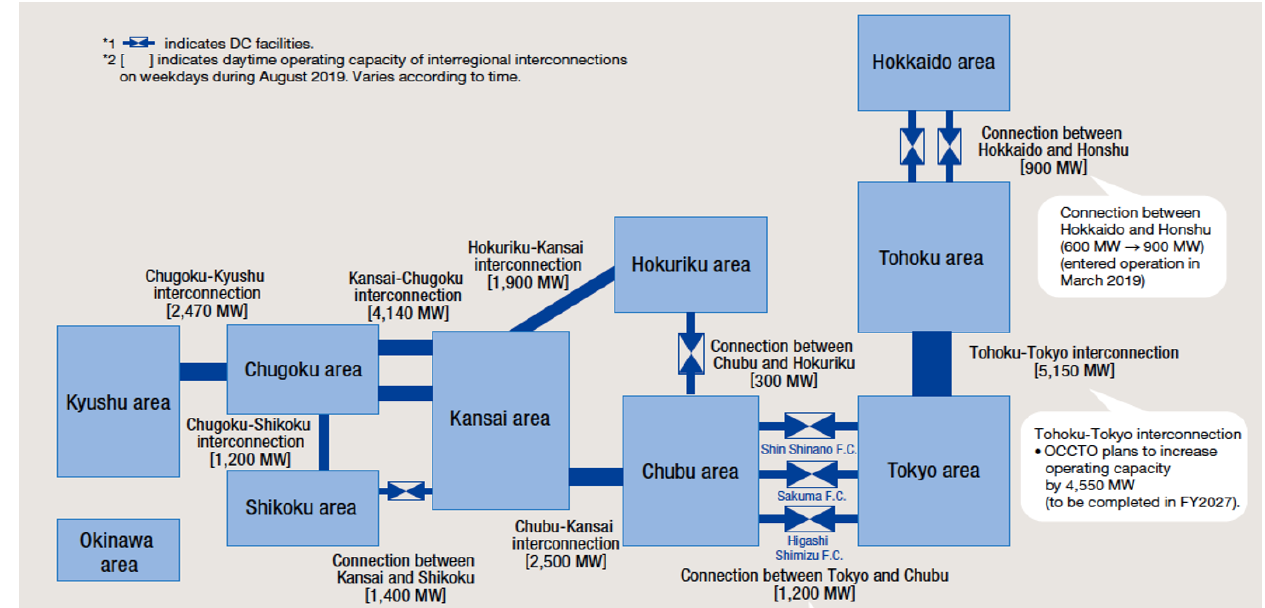
Figure 1. Illustration of the trading areas in the Japanese electricity market and the physical intercon- nections [34].